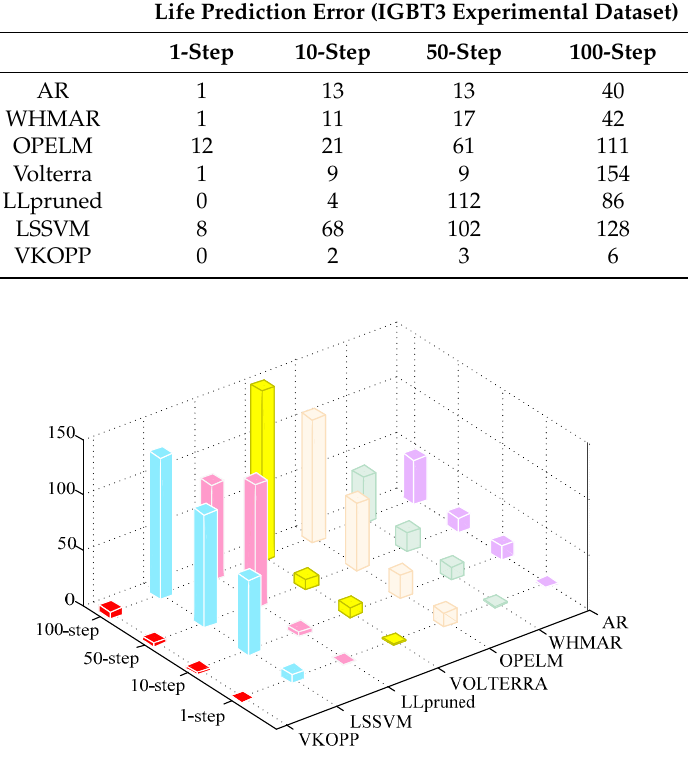
Figure 11. The three-dimensional histogram of the life prediction error results for different methodologies.